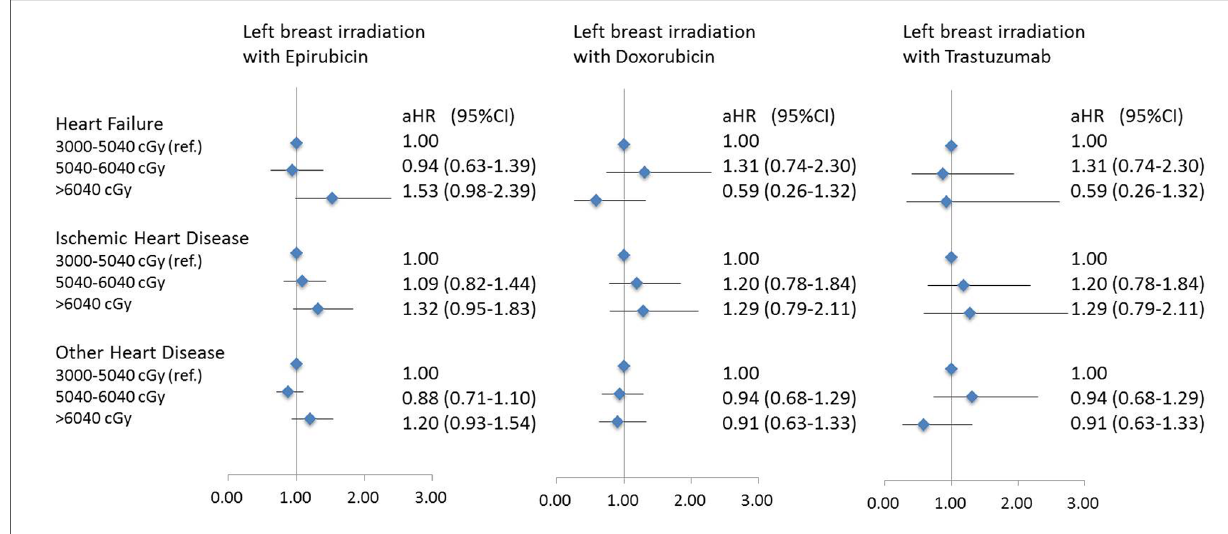
FIGURE 2 A forest plot for demonstrating heart disease risk in patients with left breast irradiation according to three main systemic anti-cancer agents and different radiation dose.